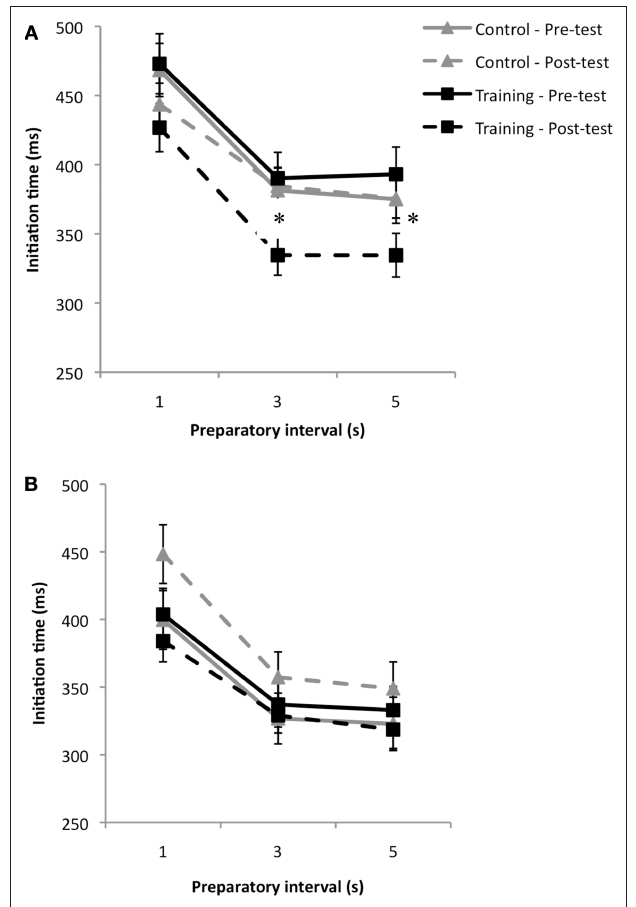
FiGure 4 | mean initiation time (ms) in the short temporal window of the choice rT task as a function of preparatory intervals at pre-test (solid line) and post-test (dashed line), in the lower fit (A) and the higher fit groups (b) (bars represent standard errors).